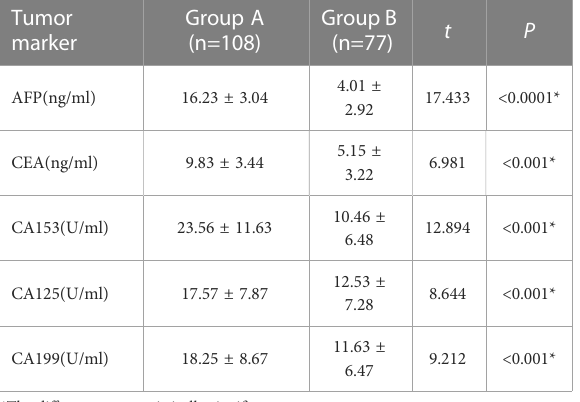
TABLE 2 Comparison of tumor markers between group A and group B. Tumor marker